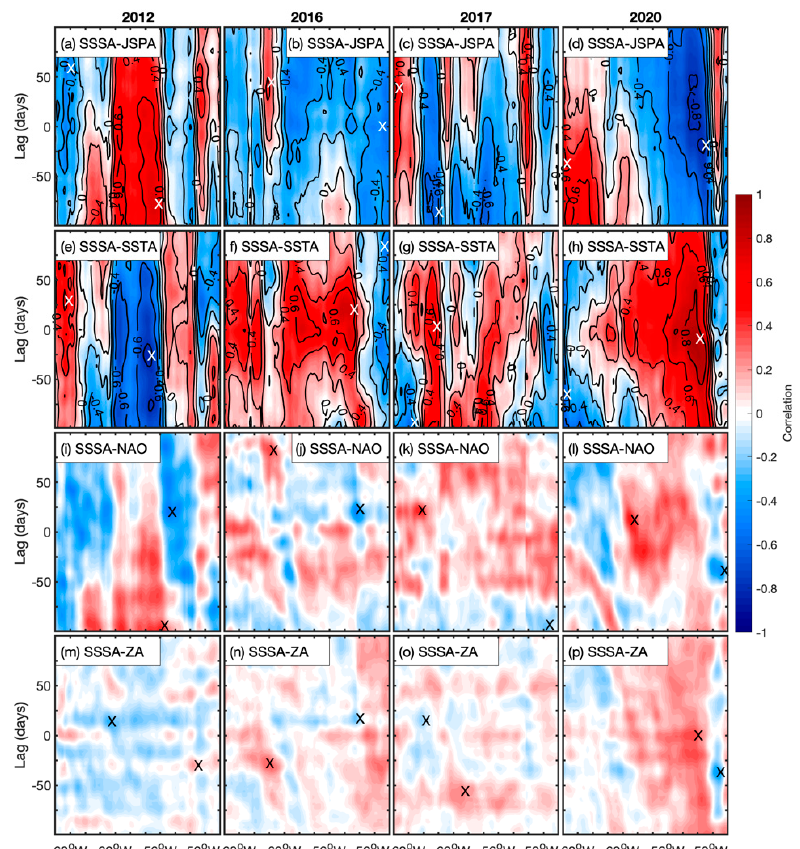
Figure 13. Time Lag cross–correlation composites of atmospheric parameters (JSPA, ZA, NAO), SSTA, and SSSA for 2012 ( a , e , I , m ), 2016 ( b , f , j , n ), 2017 ( c , g , k , o ), and 2020 ( d , h , l , p ). SSTA (°C), Z anomaly (ZA) (hm 2 /s 2 ) at 300 hPa, and SSSA (psu), where averaged averages were taken over 40–48°N. JS position anomaly (JSPA) (°N) was calculated from the daily latitude minus the mean latitude of the daily strongest winds at 300 hPa across 23–60°N in the North Atlantic. Xs marked the location of the minimum and maximum correlation between each parameter. For correlations that were difficult to differentiate ( a – c , e – g ), thin contours were added.